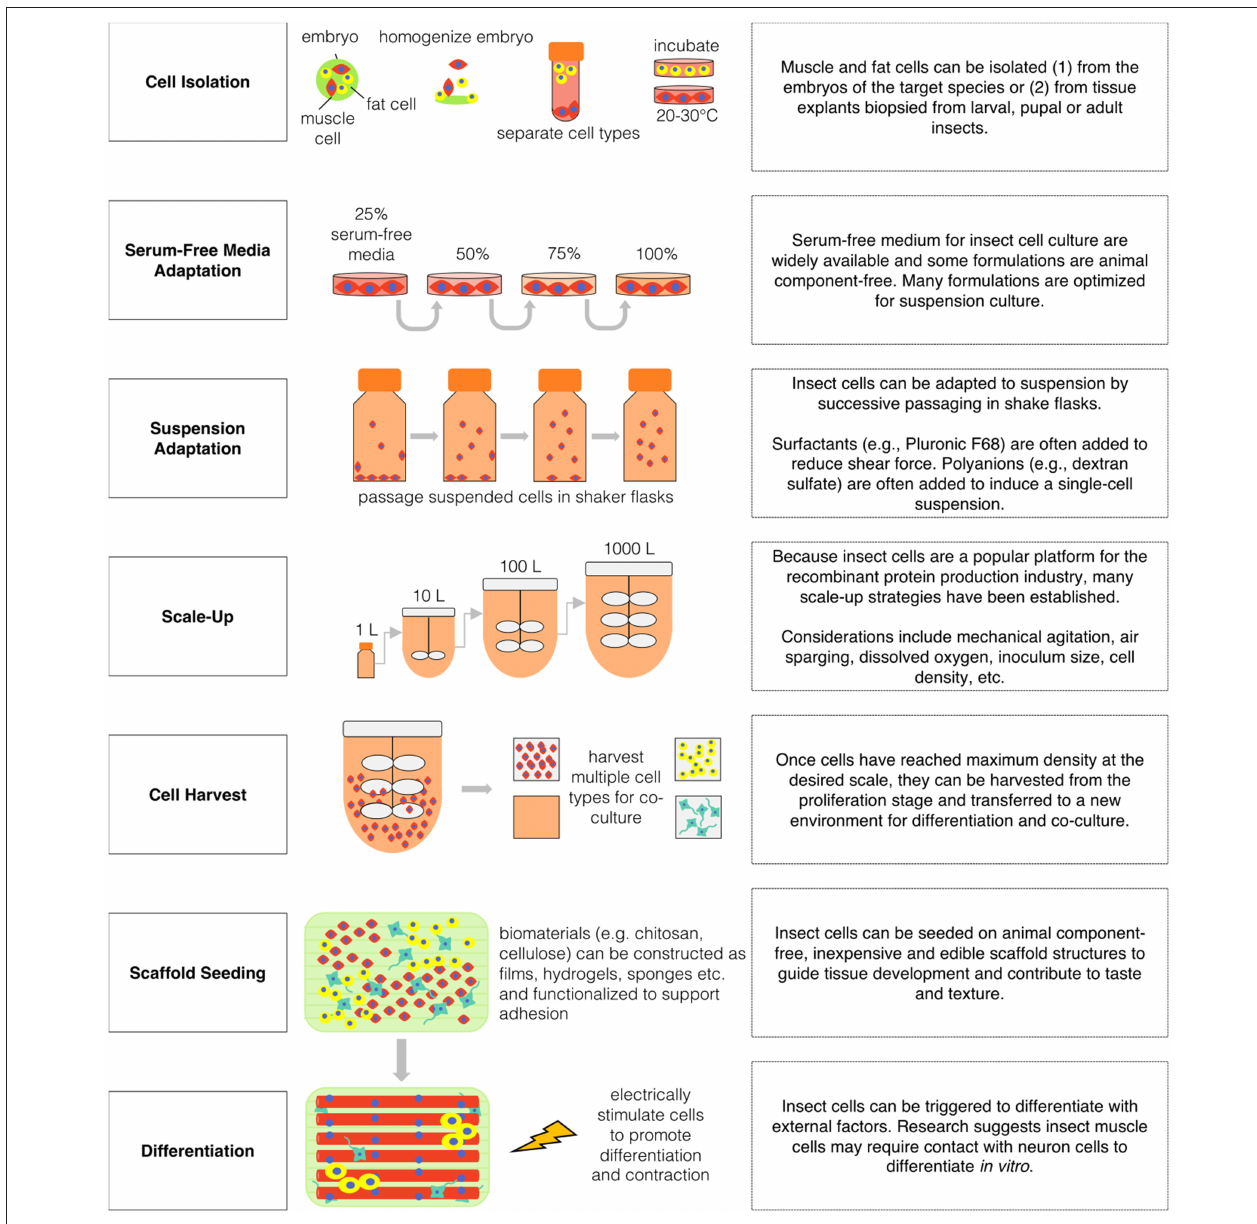
FIGURE 3 | Hypothetical production scenario for insect-based cultured